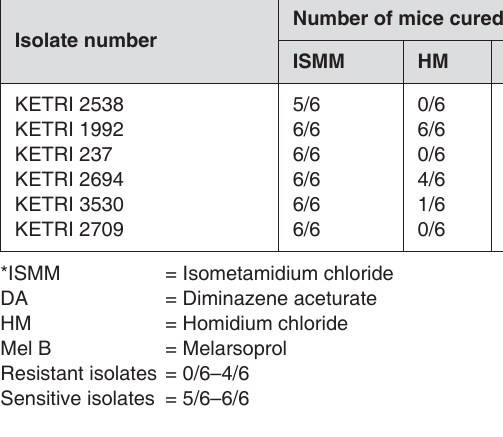
TABLE 2 Sensitivity of T.b. rhodesiense isolates to different trypanocidal drugs